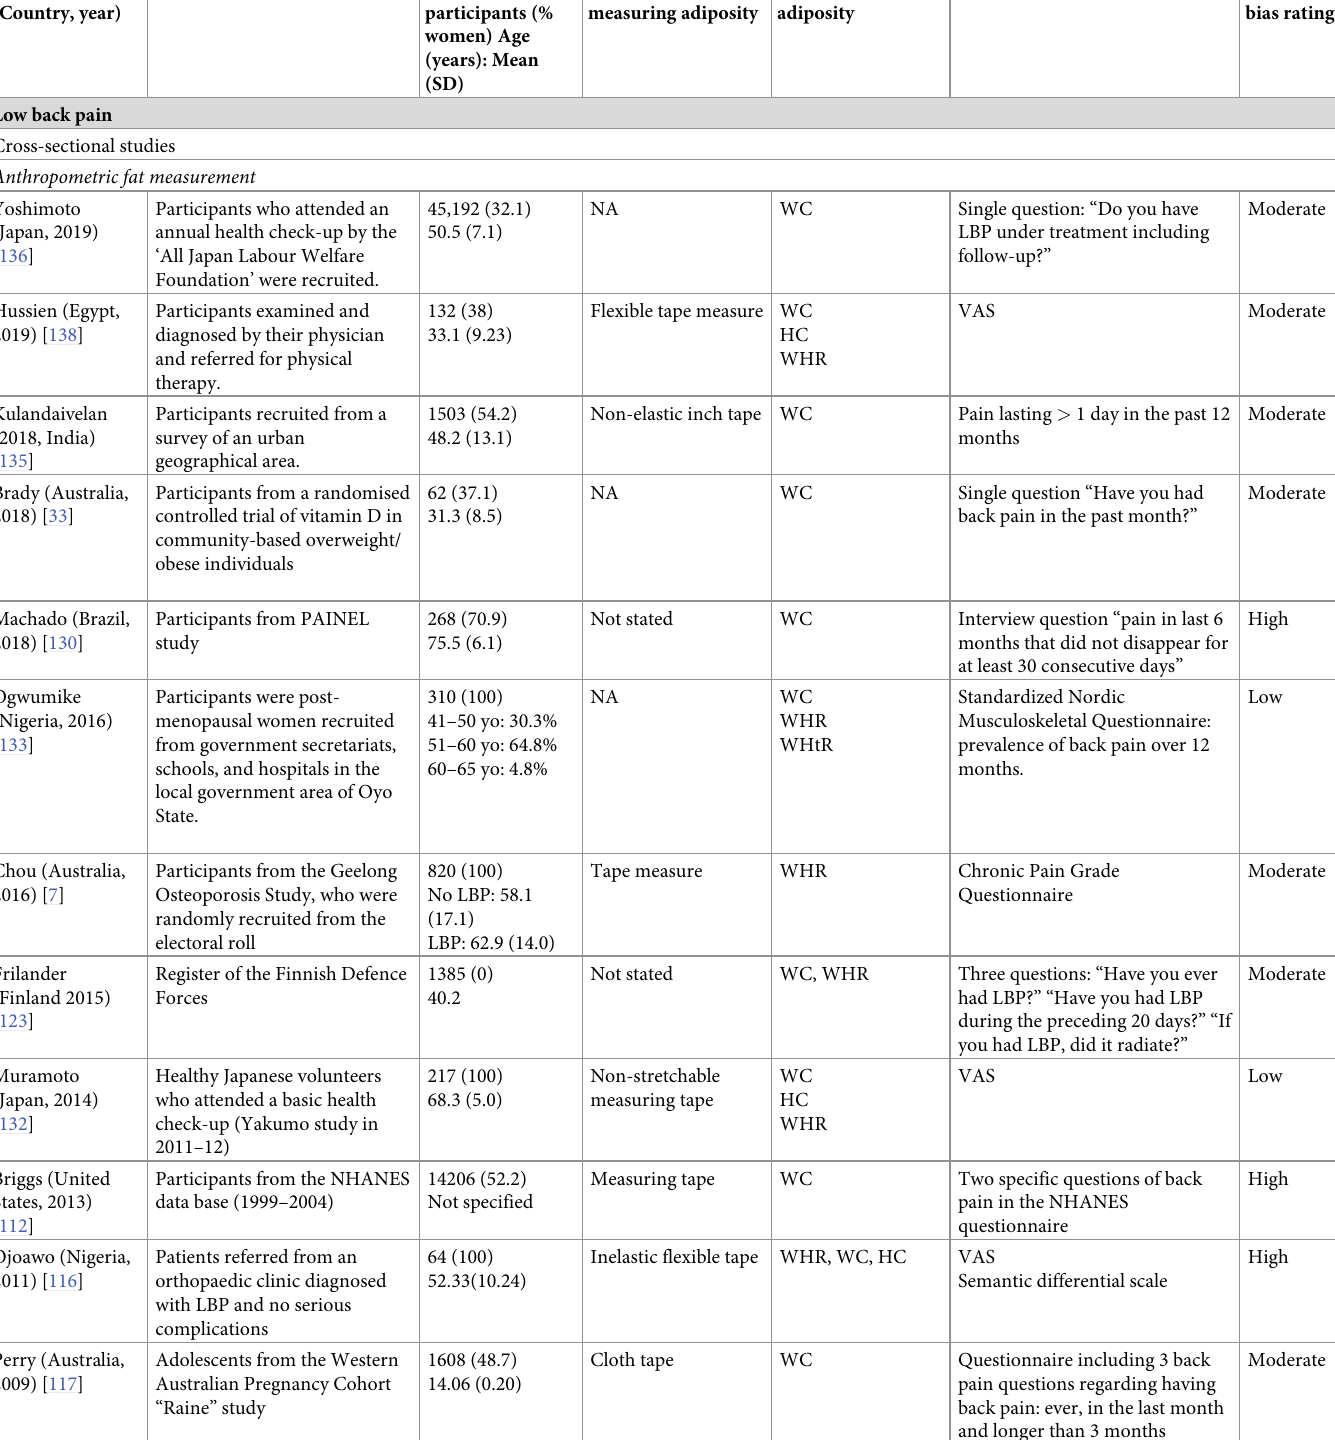
Table 1. Characteristics of studies investigating the relationship between adiposity and back and lower limb pain. Author (Country,